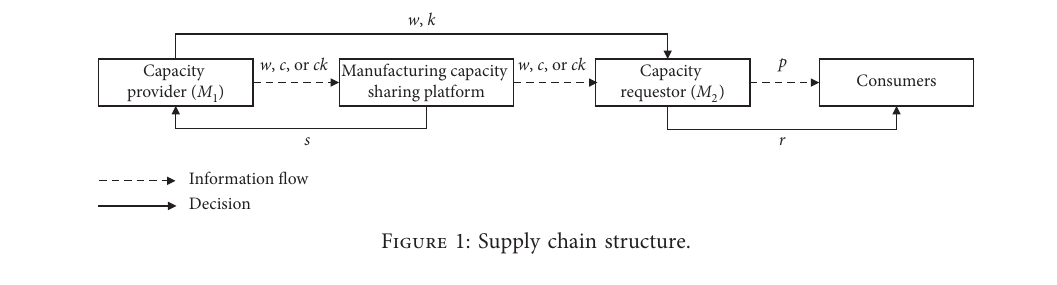
Figure 1: Supply chain structure.